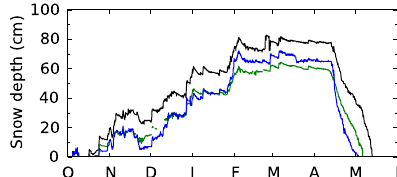
Figure 6. Snow depths measured in the IOA (black line), in the forest (green line) and on the wetland (blue line) for the winter of